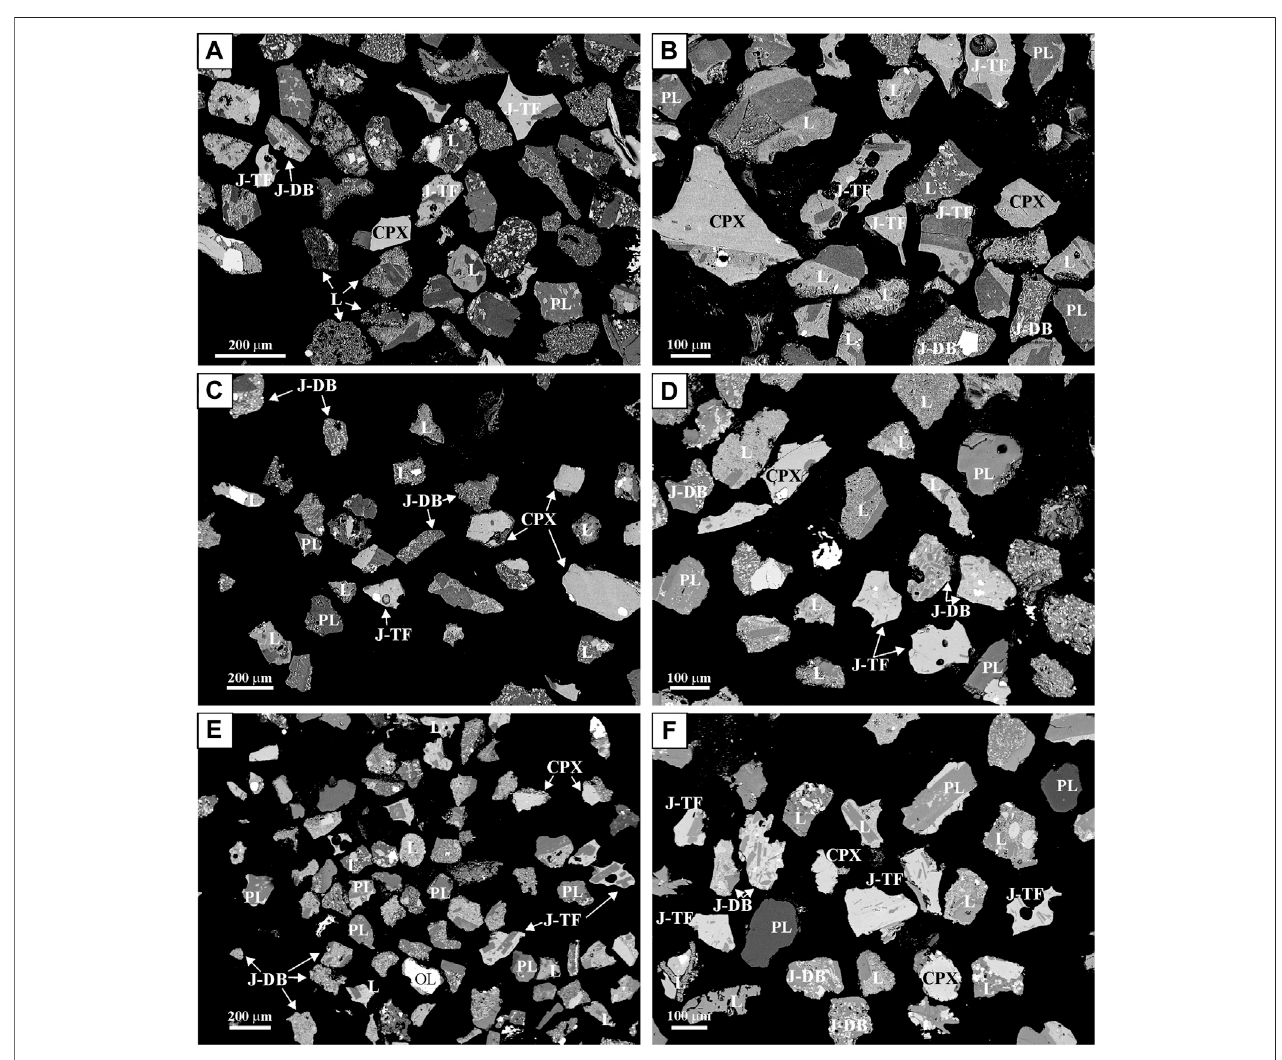
FIGURE 6 | Representative back-scattered SEM images acquired at a low resolution and used for componentry analyses of ash fragments (2 < phi < 3): (A) 24Dec2018sample NSEC+BN; (B) 01Feb2019sample BN; (C) 26Feb2019sample NEC; (D) 08Feb2019sample NEC; (E) 19Feb2019-3sample NEC; (F) 20Feb2019 sample